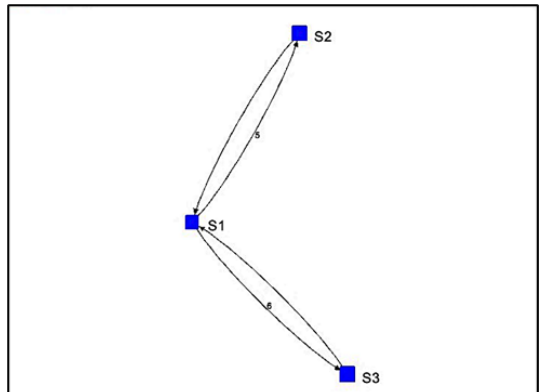
Figure 15. Algorithm 1 ’ s estimation of Path 3.